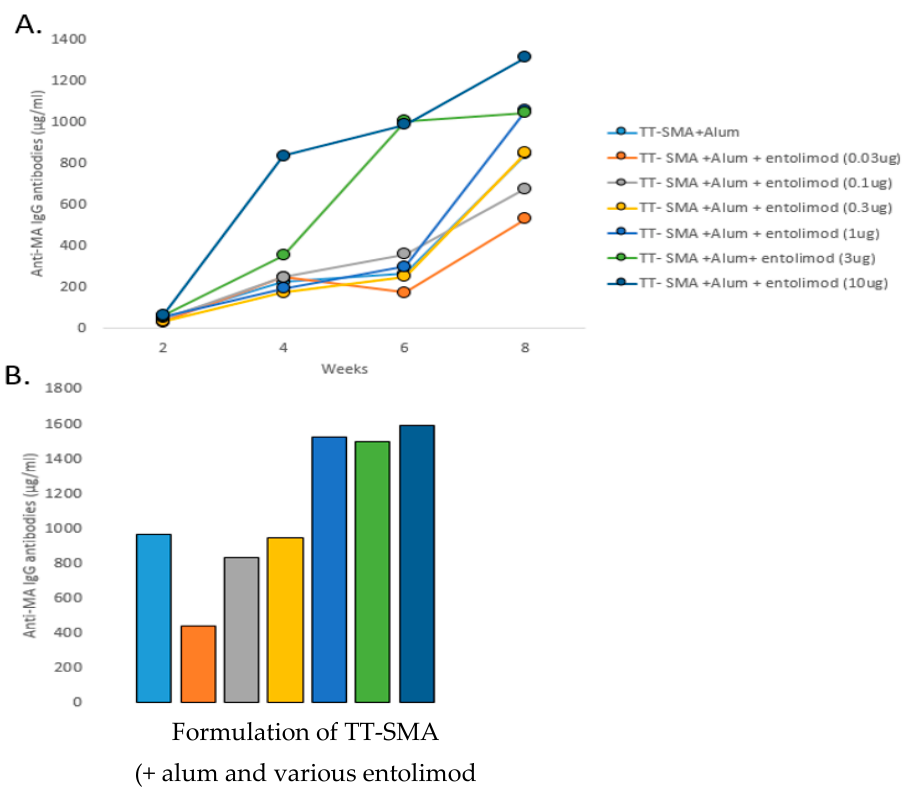
Figure 1. Immunopotentiating effects of entolimod adjuvant. ( A ) IgG anti-MA antibody levels in mice vaccinated with TT-SMA (32 ug) in the presence and absence of alum or entolimod in serum collected at 2, 4, 6, and 8 weeks post initial vaccination. Data are presented as levels of antibody in pooled samples from each group (n = 5/group). ( B ) Week 10 anti-MA antibody levels across all groups.